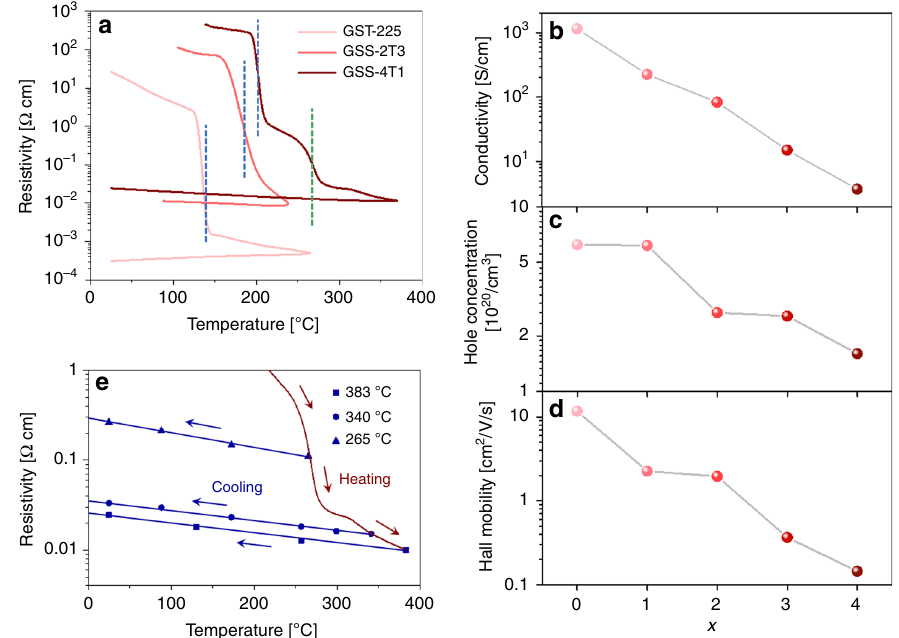
Fig. 4 Electronic properties of Ge 2 Sb 2 Se x Te 5 − x alloys. a Temperature dependence of resistivity of Ge 2 Sb 2 Te 5 , Ge 2 Sb 2 Se 2 Te 3 , and Ge 2 Sb 2 Se 4 Te 1 (GSS4T1) upon annealing: the distinct drop marked by blue dotted lines correspond to crystallization of the amorphous phase to the metastable cubic phase, whereas the green dotted line labels the transition towards the stable hexagonal phase. b Hall conductivity, c hole concentration, and d Hall mobility of c-Ge 2 Sb 2 Se x Te 5 − x ; for all compositions, the fi lms were annealed 50 °C above the amorphous-to-cubic transition temperature. e Temperature-dependent resistivity of GSS4T1 annealed at different three temperatures: 265, 340, and 383 °C. The temperature coef fi cients of resistivity are negative in all cases evidenced by the negative slope of the cooling curves